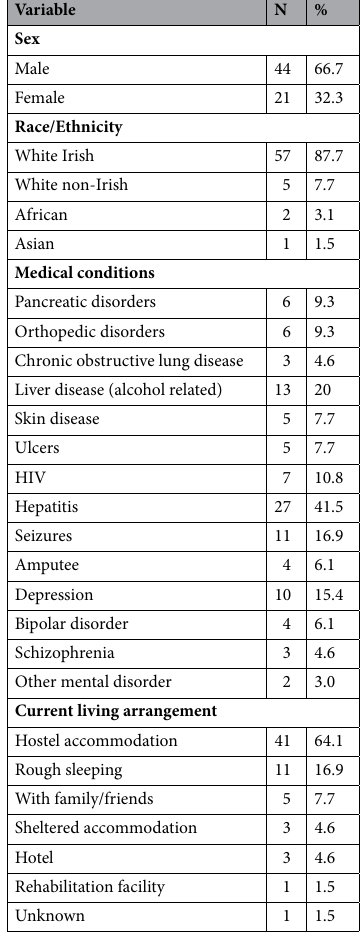
Table 1. Demographic characteristics of participants.